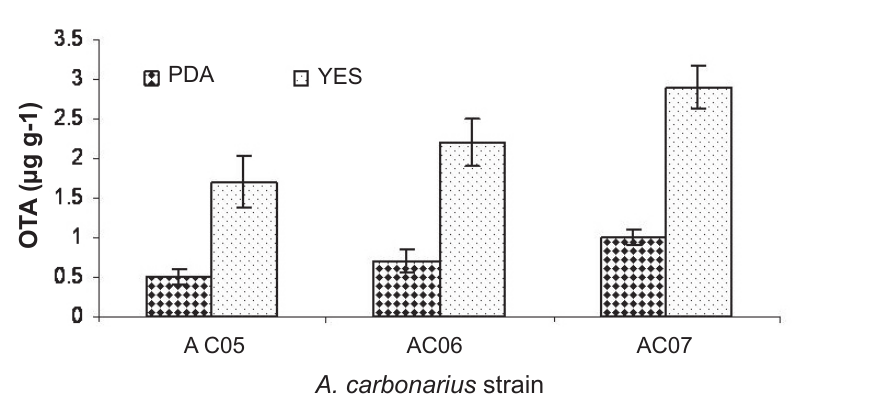
Figure 1. OTA production by A. carbonarius strains in two agar media after 9 days of incubation at